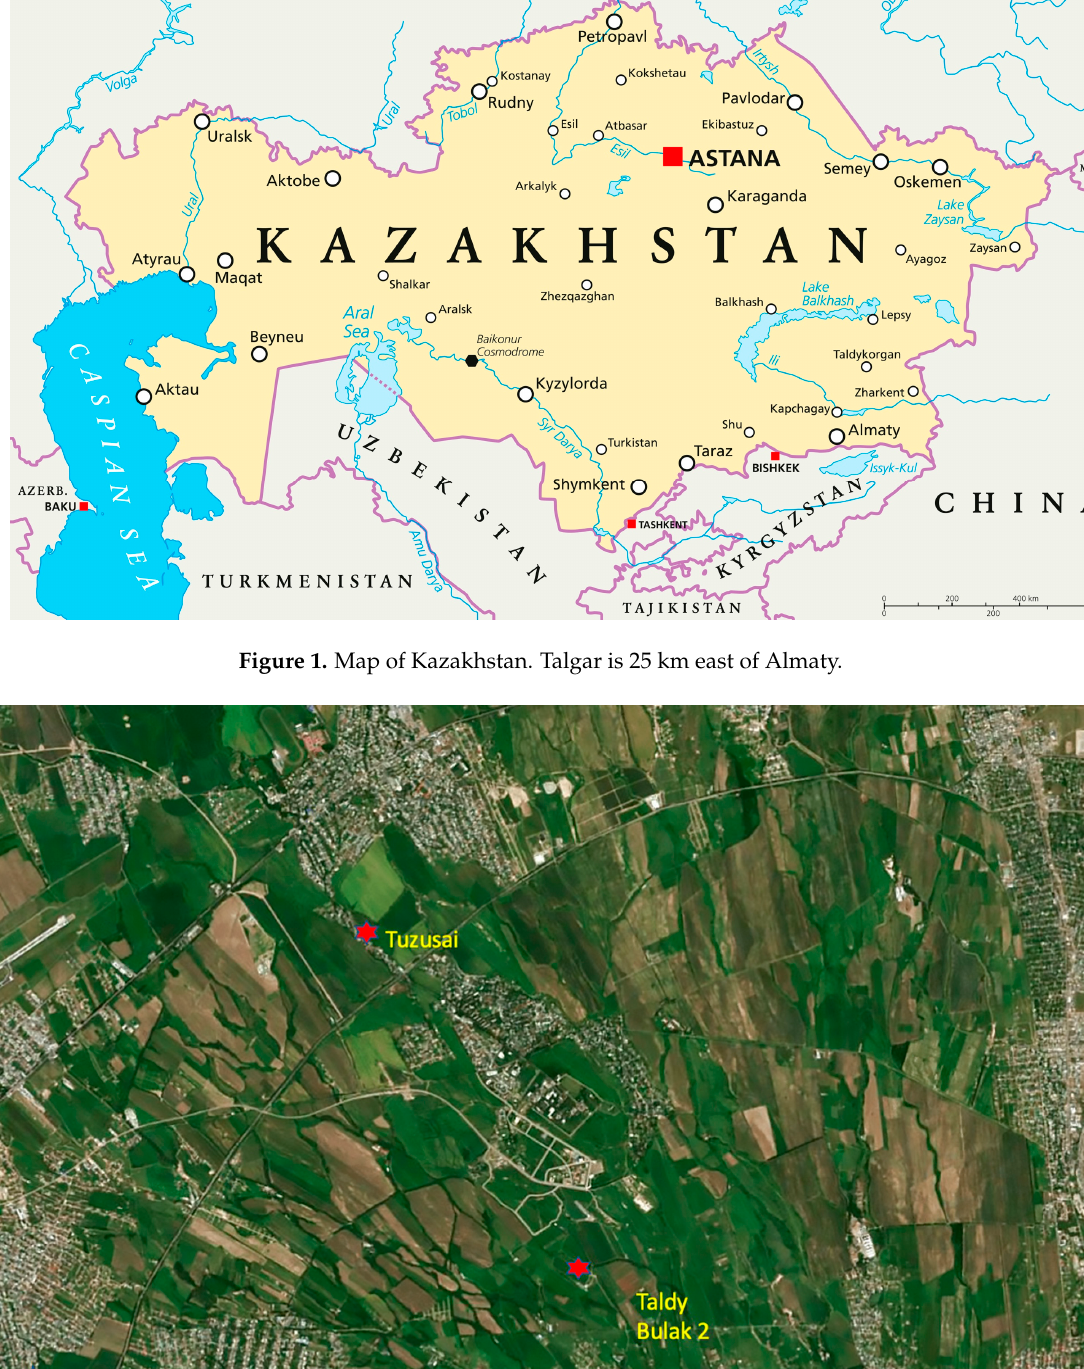
Table 1. List of special finds, context and feature association, and measurements.